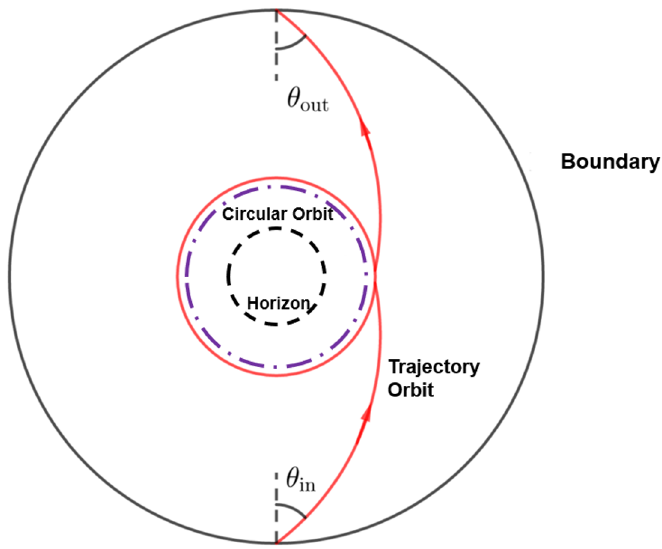
Figure 7 . The dominant contribution to the final response function comes from the trajectory as close to the circular orbit as